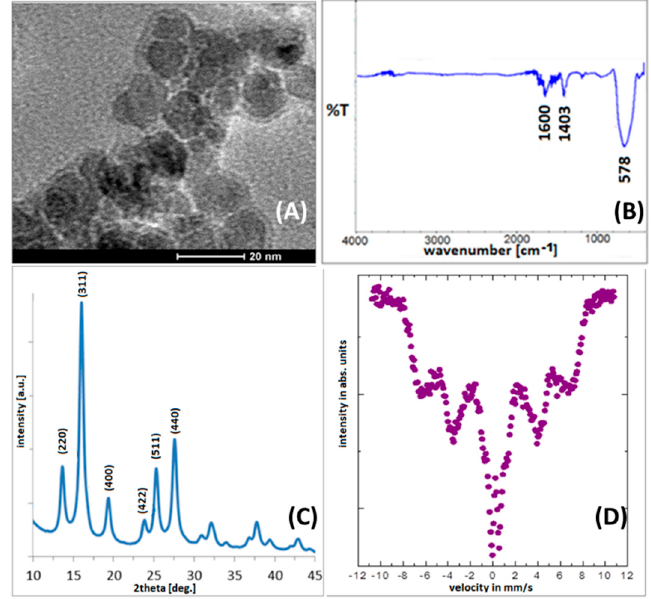
Figure 2. ( A ) TEM images of Mn 0.2 Fe 2.8 O 4 nanoparticles; ( B ) IR spectra of pristine nanoparticles and with attached SA, AA, and 16-PHDA linkers, respectively; ( C ) X-ray diffractogram of Mn 0.2 Fe 2.8 O 4 ; ( D ) Mössbauer spectrum of Mn 0.2 Fe 2.8 O 4 nanoparticles.